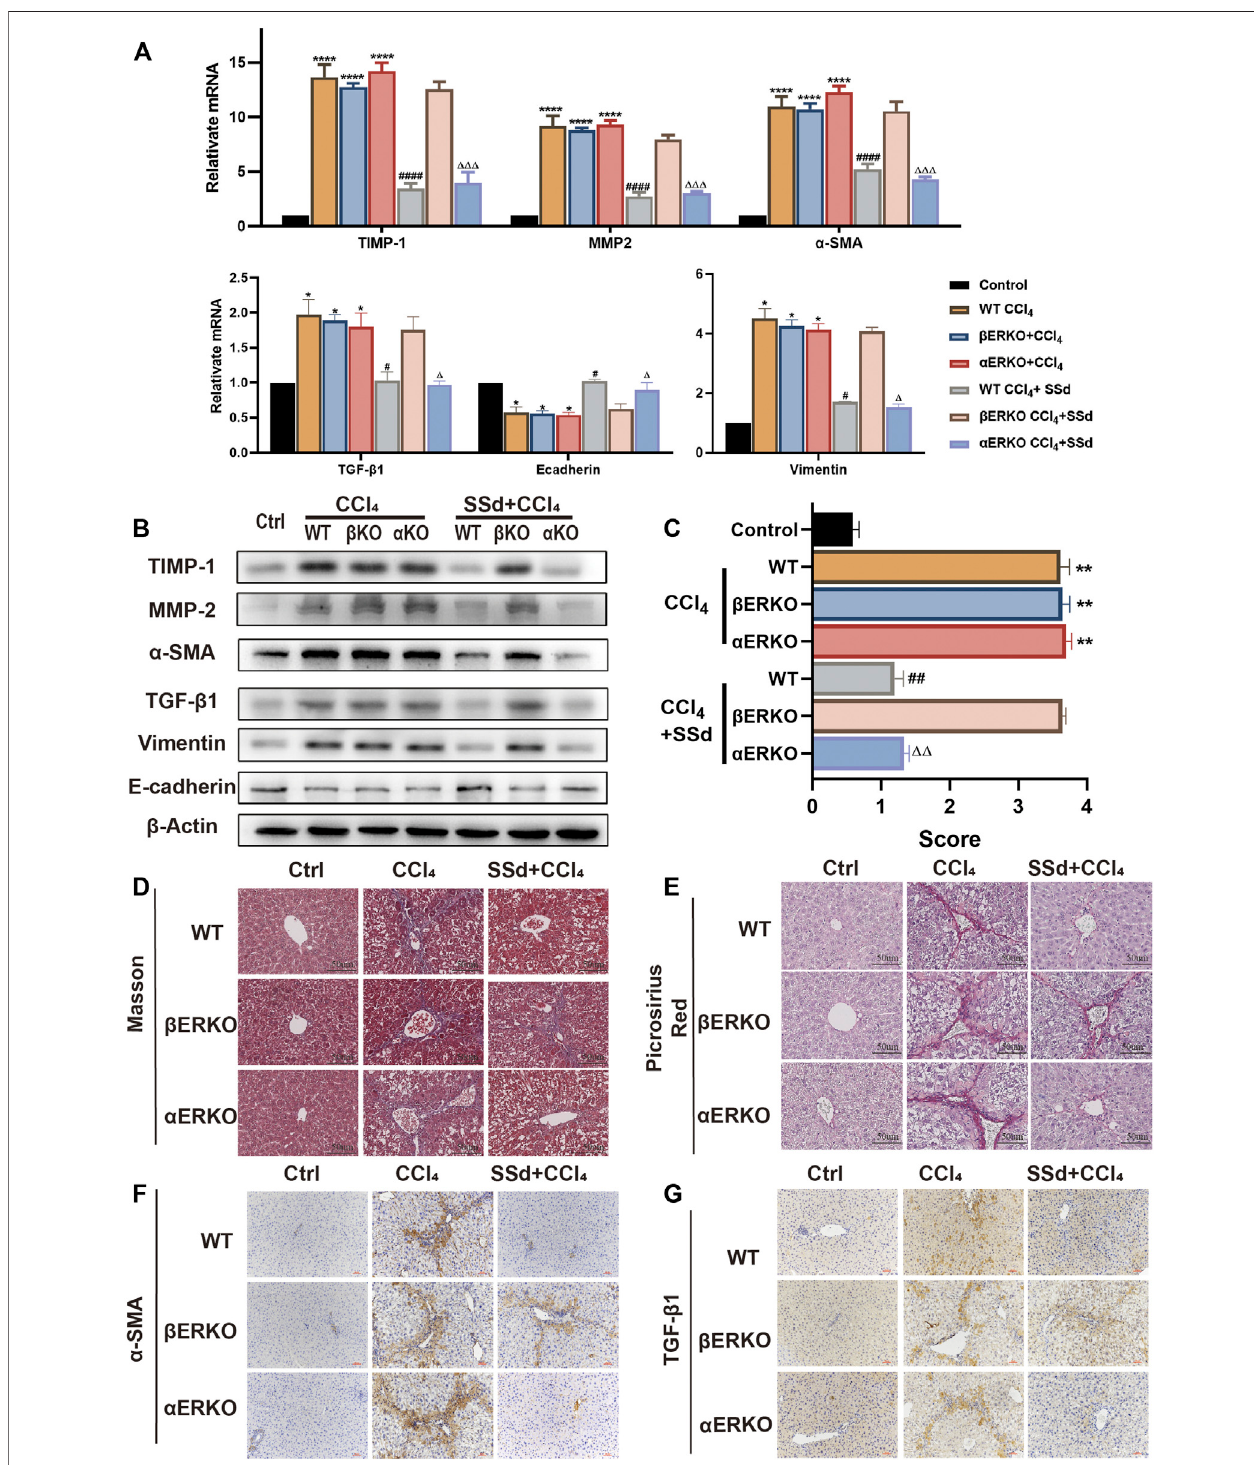
FIGURE 6 | De fi ciency of ER β , but not ER α , blocks the inhibitory effect of SSd against CCl 4 -induced liver fi brosis (A,B) . α -SMA, TGF- β 1, TIMP-1, MMP-2, E-cadherin, and Vimentin mRNA and protein expression were tested by RT-PCR and WB in liver tissues, n = 3. (C) liver fi brosis scores in each group, n = 6. (D,E) Liver fi brosis wasdetected byMassonstaining,picricacid-Siriusstaining(×200; scale bar:50 μ m). (F,G) IHC detection oftheexpression of α -SMA, TGF- β 1(×200; scalebar: 100 μ m). Data are expressed in mean ± SEM; * p < 0.05, ** p < 0.001, **** p < 0.0001, CCl 4 treated versus control in WT and ERKO mice; # p < 0.05, ## p < 0.01, Δ P < 0.05, ΔΔ P < 0.01, ΔΔΔ P < 0.0001, SSd + CCl α ERKO mice. #### p < 0.0001, SSd + CCl 4 group versus CCl 4 group in WT mice; 4 group versus CCl 4 group in